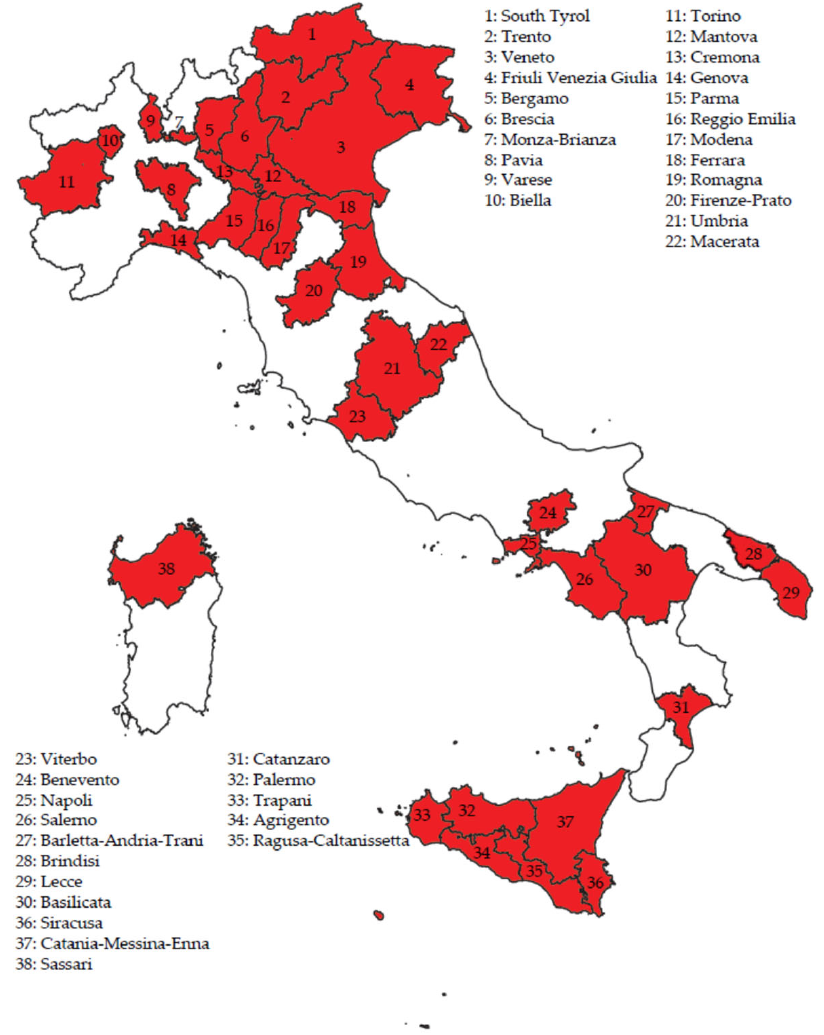
Figure 1. Geographic distribution of the 38 cancer registries participating in the study on time trends in net survival from vulvar squamous cell carcinoma in Italy between 1990 and 2015 (total resident female population 15,358,161 in 2015).